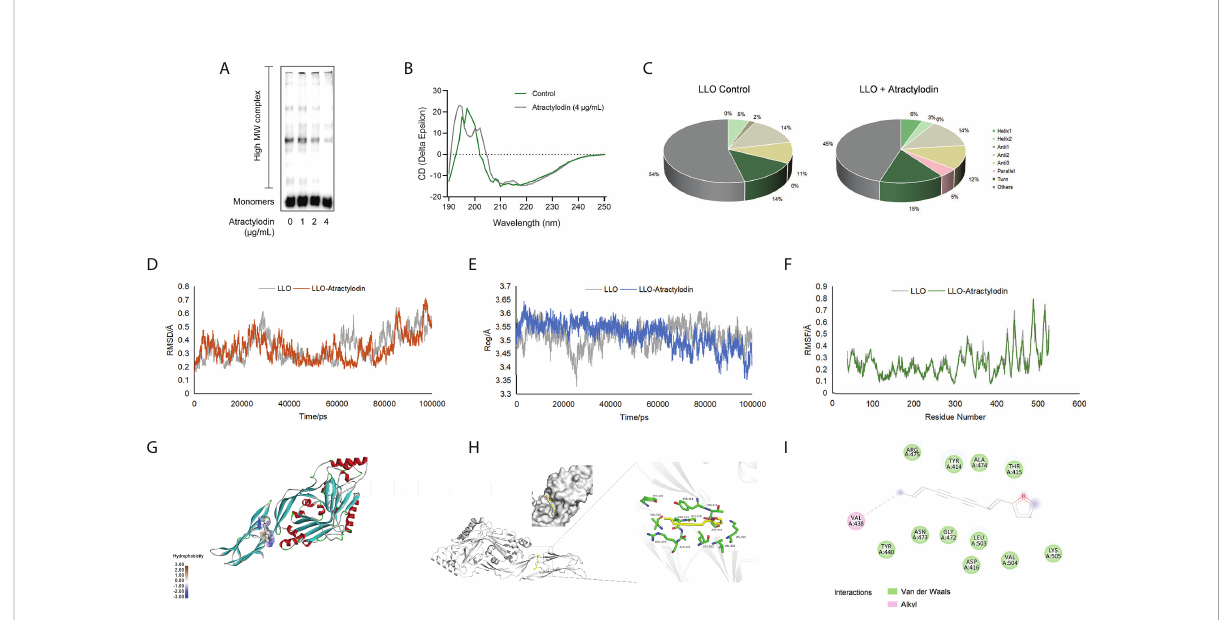
FIGURE 2 Molecular interactions between atractylodin and LLO structure. (A) The effect of atractylodin on LLO oligomerization was determined with an oligomer formation analysis. (B, C) The circular dichroism (CD) spectroscopy analysis of LLO in the presence or absence of 4 m g/mL atractylodin. The root mean square deviation (RMSD) (D) , radius of gyration (Rog) (E) and root mean square fl uctuation (RMSF) (F) in free LLO protein and LLO-atractylodin complex were analyzed to determine the stability of the system involved in interactions between LLO and atractylodin. (G, H) The binding mode between atractylodin and LLO. (I) Interaction details and energy decomposition analysis of docked